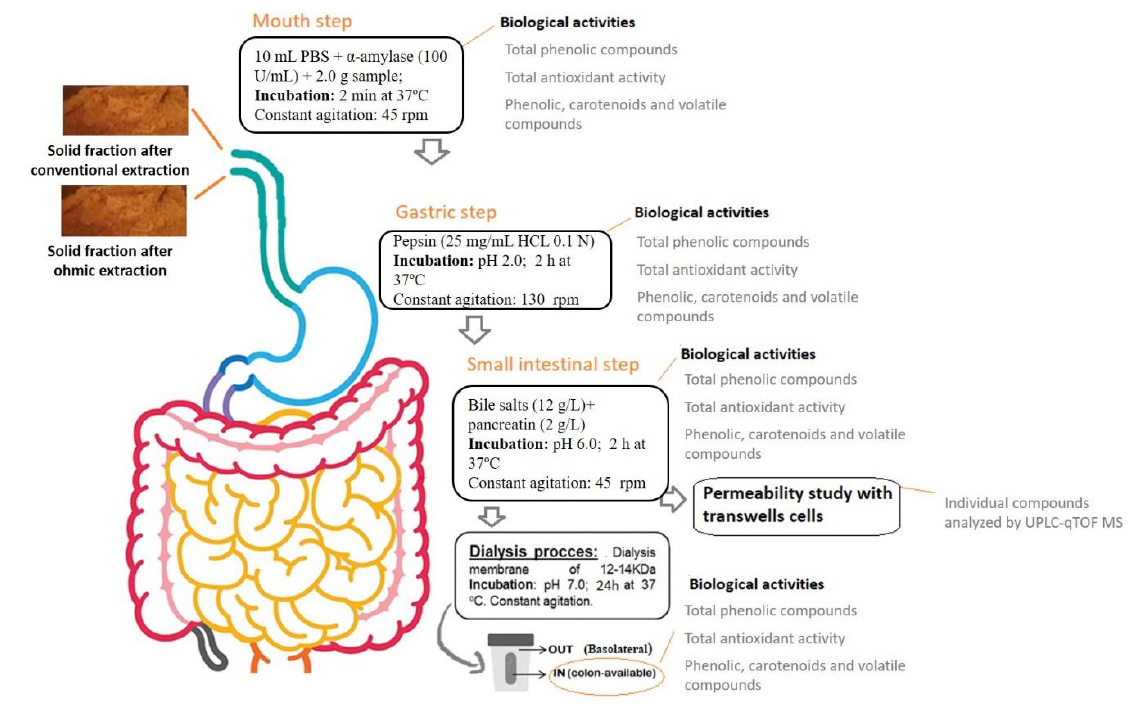
Figure 1. Gastrointestinal simulation and biological analysis throughout each step of digestion. During the gastrointestinal stimulation, samples were collected in each step—mouth, stomach, small intestine, colon, and basolateral fraction—to analyze total phenolic com- pounds, total carotenoids, individual compounds, and metabolites (phenolic, carotenoids, and volatile compounds) by HPLC and UPLC-qTOF MS, and antioxidant activity. All analyses were performed in